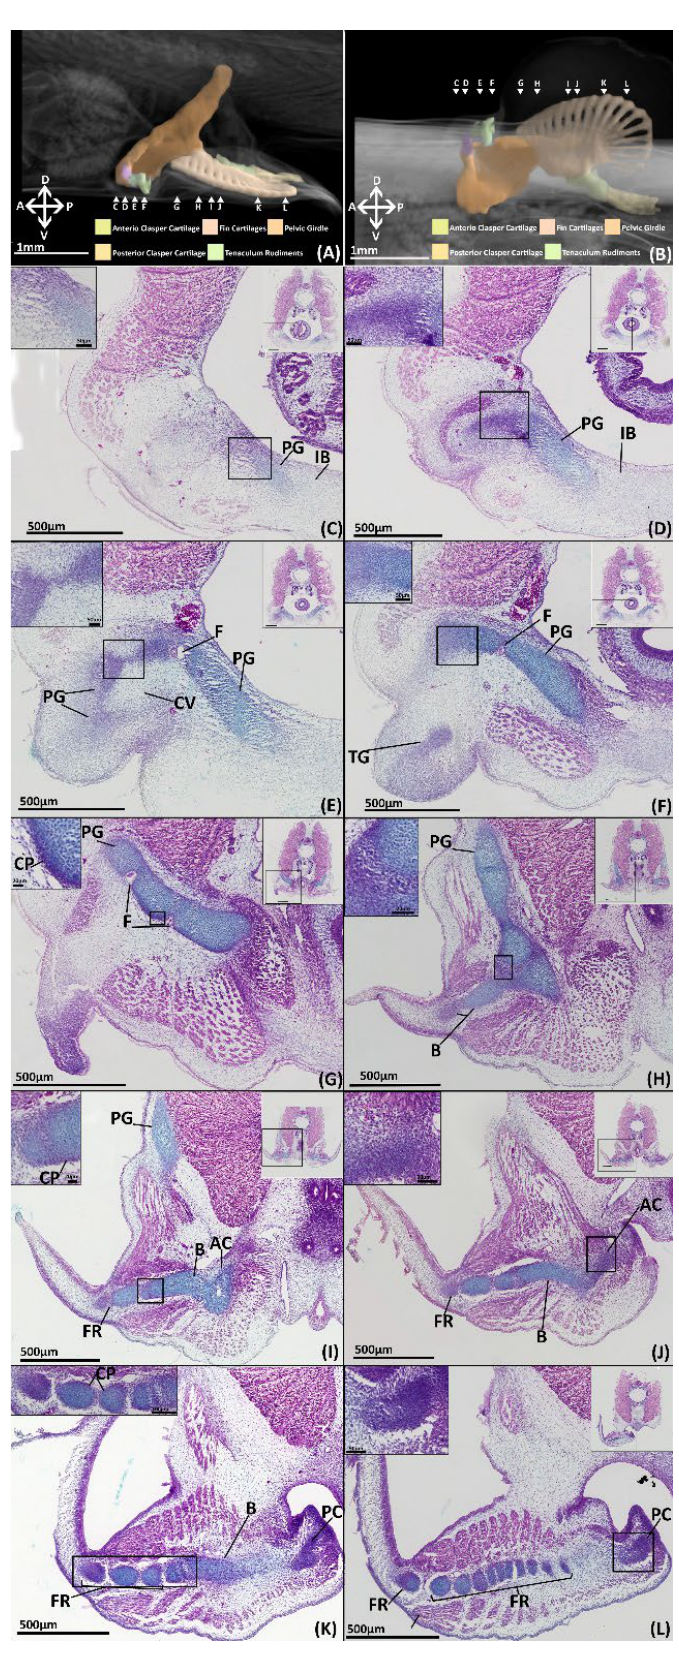
Figure 6. NanoCT models ( A , B ) and transverse paraffin sections ( C – L ) of a male stage 32